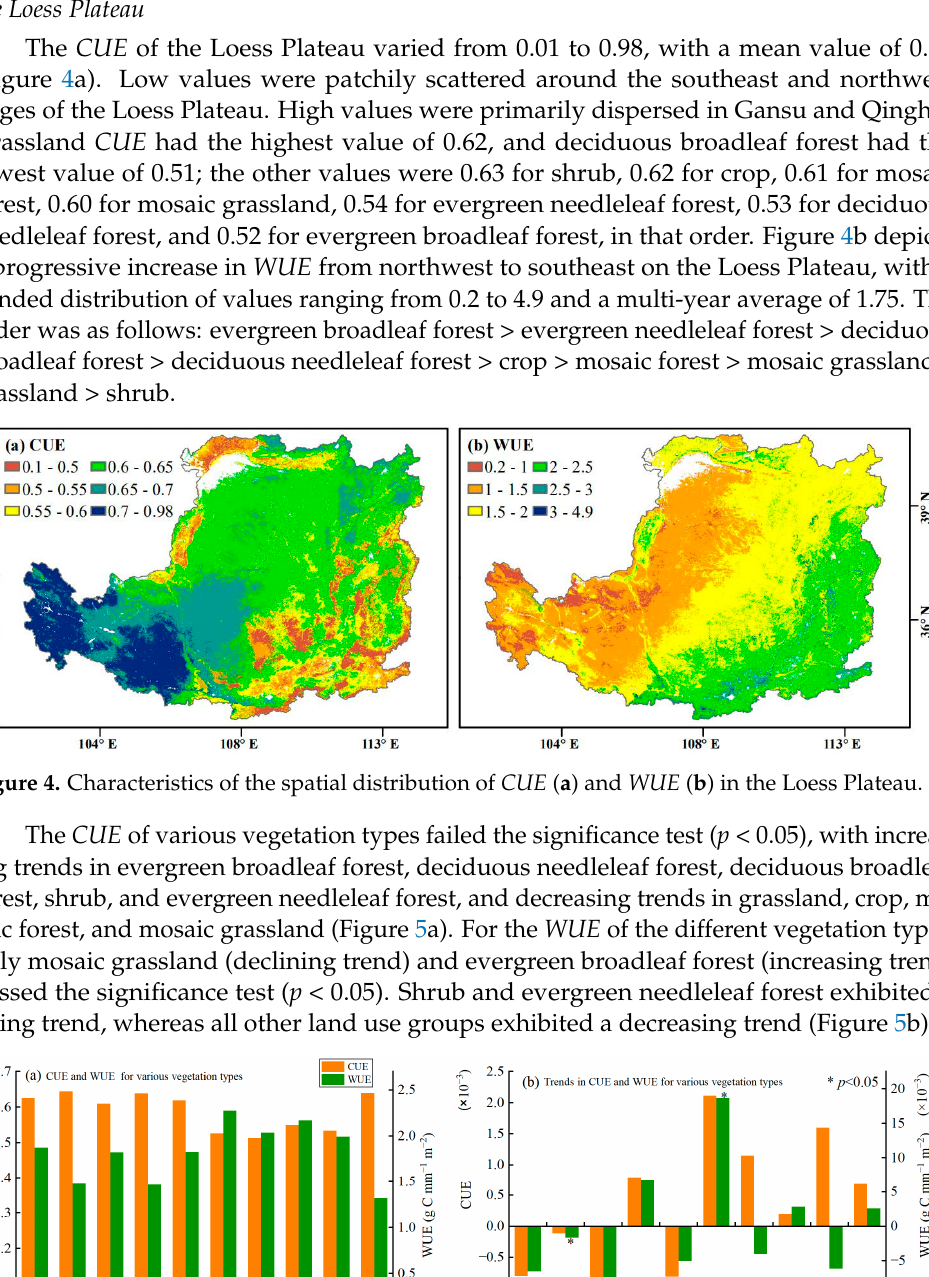
Figure 5. CUE and WUE for various types of vegetation and trend on the Loess Plateau between 2000 and 2020.